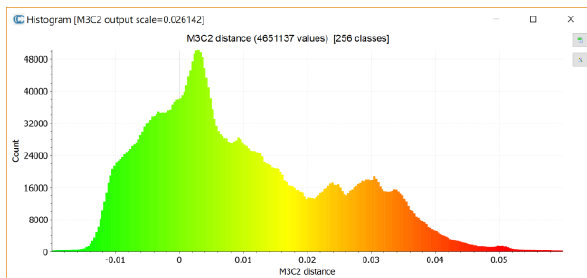
Figure 7. Histogram of distance (m) between the points of the two models obtained by M3C2 tool Furthermore, by a suitable choice of the colour scale another trend can be highlighted.